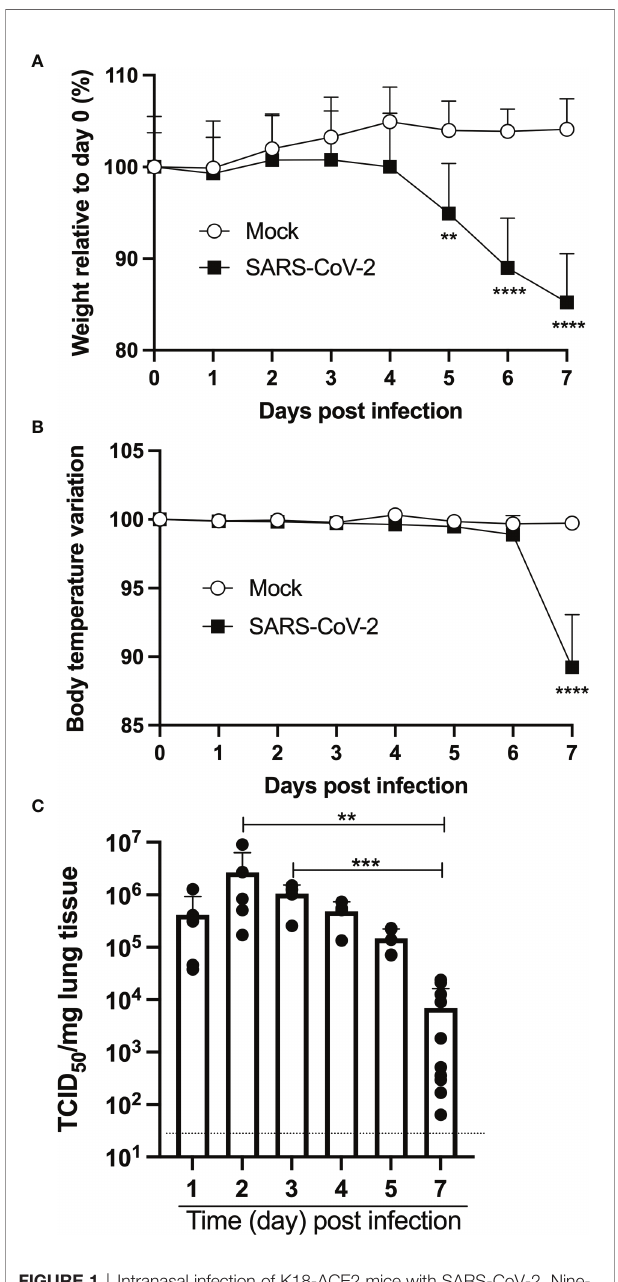
FIGURE 1 | Intranasal infection of K18-ACE2 mice with SARS-CoV-2. Nine- week old female K18-ACE2 mice (n=5-10/group) were inoculated intranasally with 4.5x10 4 TCID 50 /25ul. Every day for 7 days, weight (A) , body temperature (B) and lung viral loads (C) were monitored. For A and B, two-way ANOVA with Sidak ’ s multiple comparisons: **p<0.005; ****p<0.0001. For C, ANOVA followed by Kruskal Wallis tests: **p<0.005;